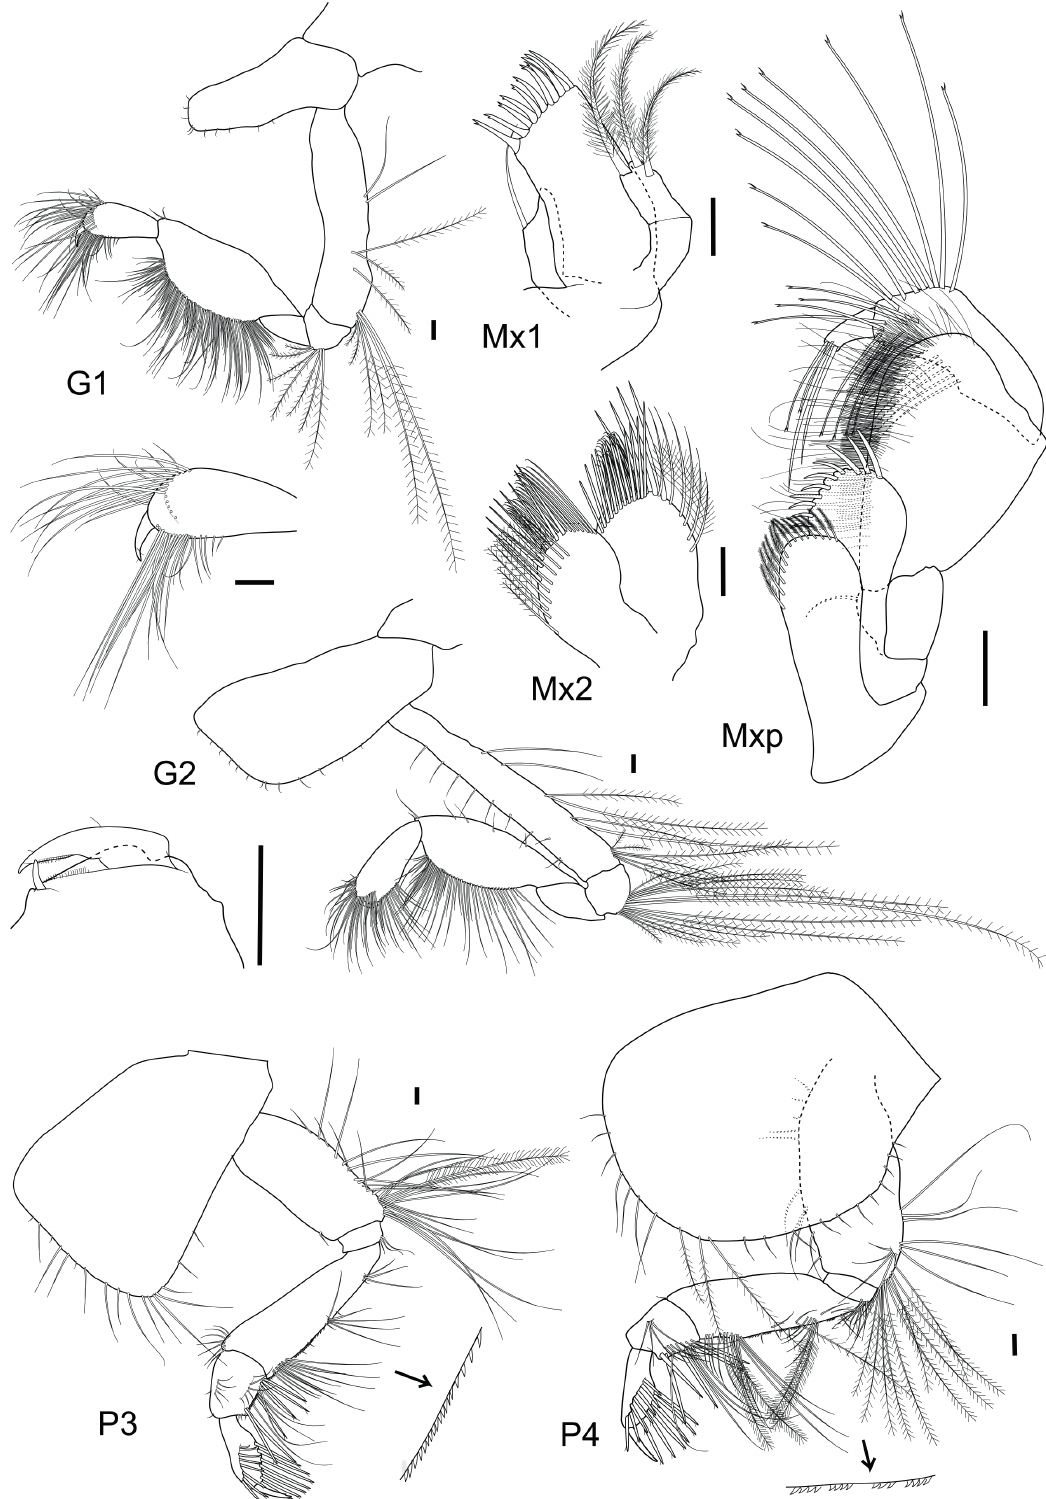
Figure 2 - Phoxocephalopsis ruffoi sp. nov. Female, 7.5 mm, MNRJ 22101: Mouthparts, gnathopods and pereopods 3 - 4. Scales = 0.1